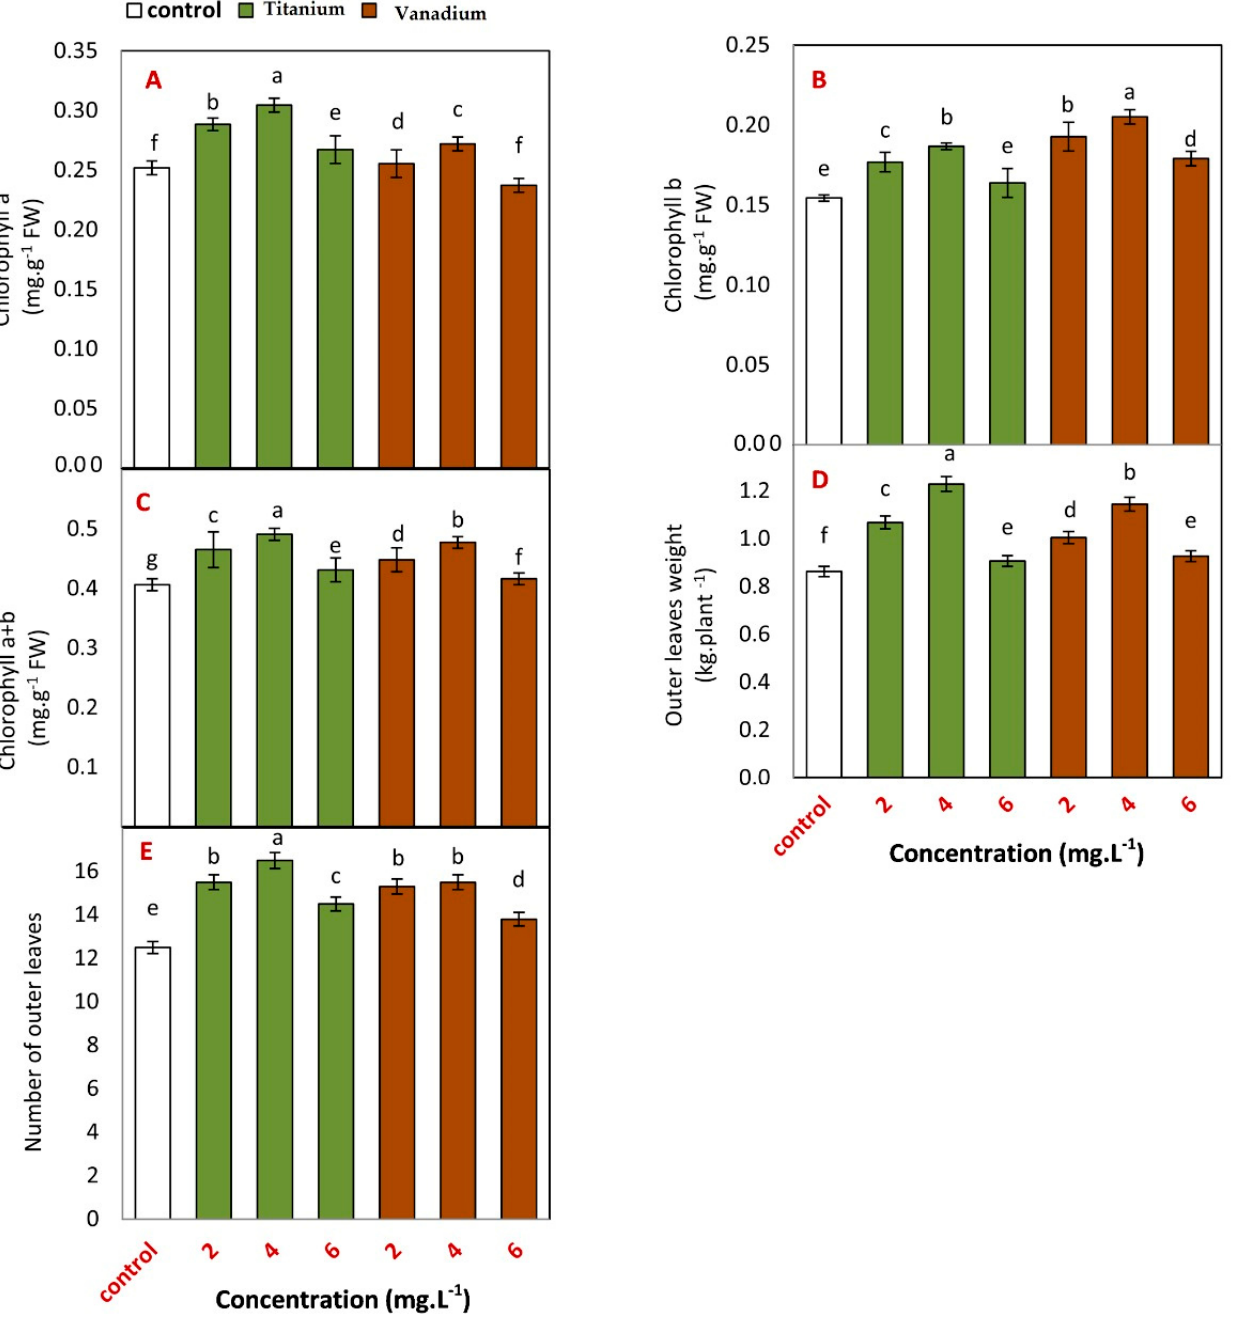
Figure 1. Chlorophyll a ( A ); chlorophyll b ( B ); total chlorophyll ( C ); outer leaves weight ( D ); and number of outer leaves ( E ) of red cabbage plants treated with Ti and V. Data are presented as means of three replicates. Different letters refer to significant difference at p < 0.05 according to the Duncan test ( n = 3).